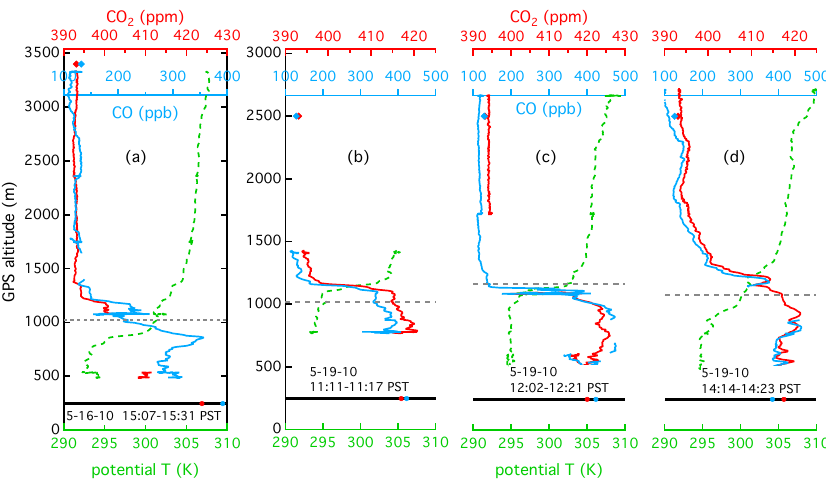
Fig. A1. Profiles of CO 2 (solid red curve) and CO (solid blue curve) mixing ratios and potential temperature (dashed green curve) determined by instruments on NOAA’s P3 over the CalNex-LA ground site in Pasadena. Circles and diamonds show the compositions of CO 2 (red) and CO (blue) at the ground site and in the free troposphere, respectively, assumed to be the background values. The horizontal black lines indicate the elevation of the sampling site. The dashed gray lines indicate the location of the top of the mixed layer determined by the ceilometer at the ground site. These profiles show the rapid transition from PBL to free troposphere and the limited entrainment of PBL CO and CO 2 into the overlying atmosphere, at least for 19 May 2010. The maximum PBLH prior to the profile of 19 May 2010 at 14:00 was 1205m, whereas the other profiles were collected at the time of the maximum PBLH. Unfortunately, the profiles determined later in the campaign did not extend low enough to intersect the PBL.